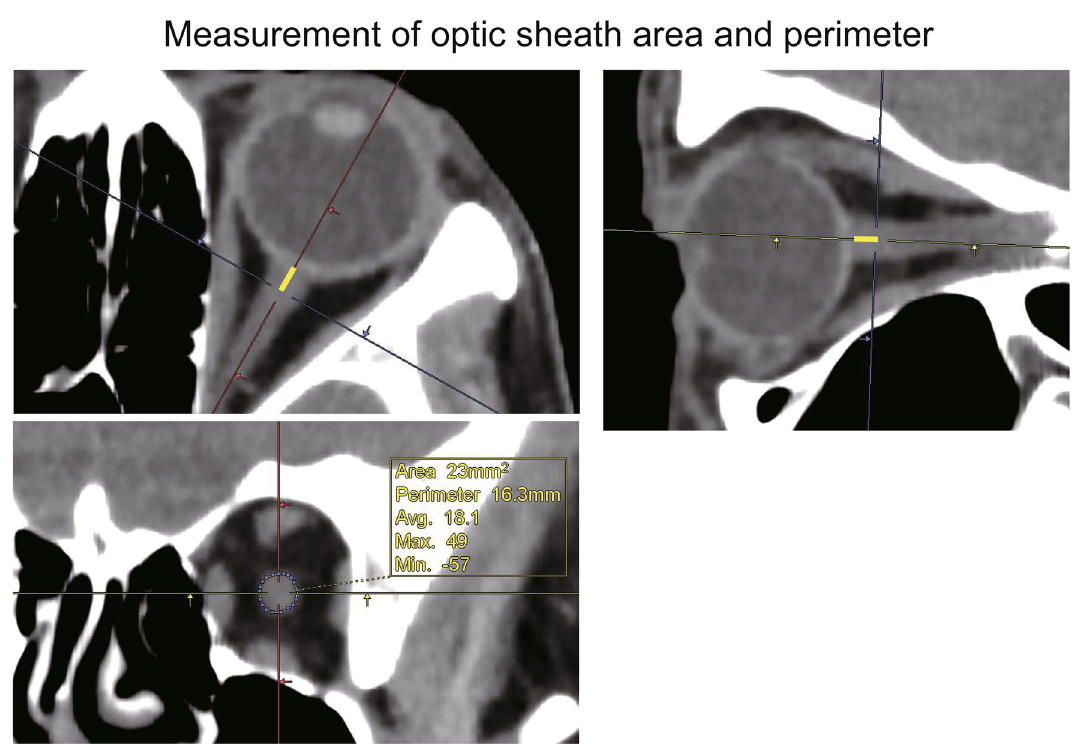
Figure 4. The optic nerve sheath area and perimeter (ONSA and ONSP, respectively) were measured 3 mm behind (yellow line) the eyeglobe on an oblique coronal